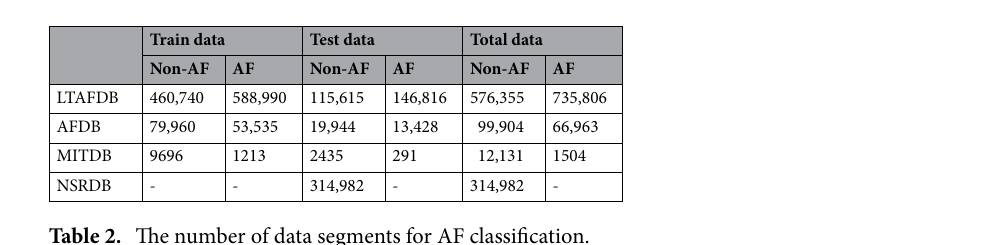
Table 2. The number of data segments for AF